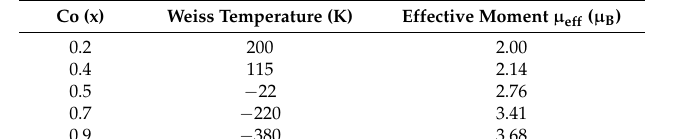
Table 1. Parameters obtained by the fitting of Curie-Weiss of Mn 3 Zn 1 − x Cu x N compounds.